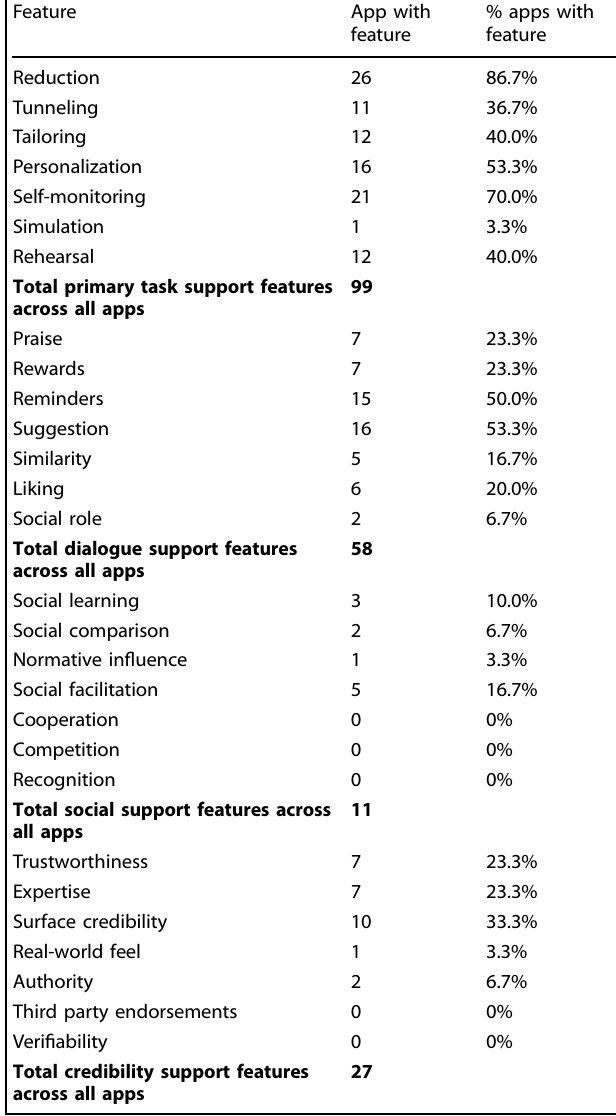
Table 4. Frequency of PSD features.